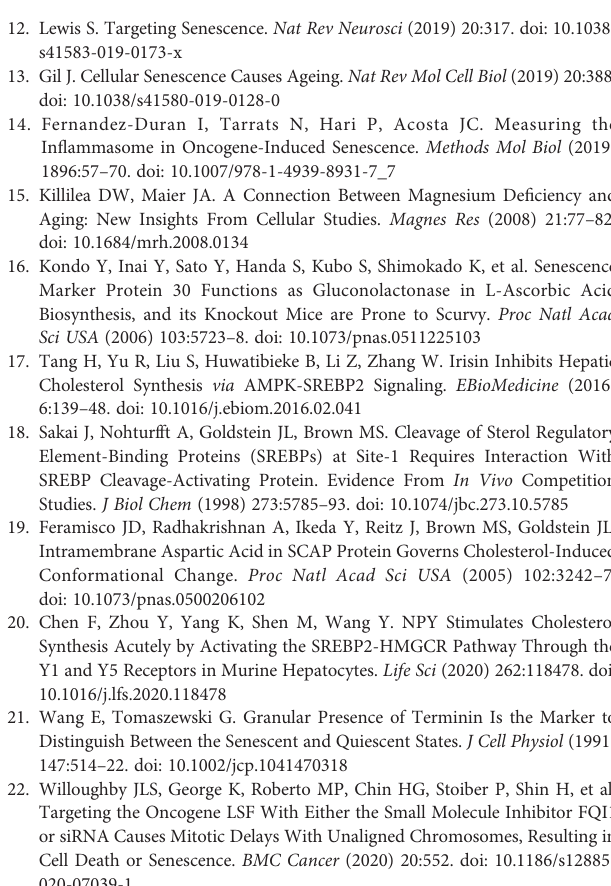
Supplementary Figure 1 | TFCP2 was up-regulated in pancreatic cancer. (A) Immunohistochemistry (IHC) was performed to examined the protein levels of TFCP2 in the pancreatic cancer tissues (cancer) and adjacent non-cancerous tissues (normal). (B) The protein levels of TFCP2 in the pancreatic tissues of KC mice aged 2 or 8 months. (C) IHC was performed to examined the protein levels of TFCP2 in the pancreatic cancer tissues with wide-type or mutant Kras. The magni fi cation was 10-fold. Supplementary Figure 2 | SREBP2 and HMGCR was up-regulated in pancreatic cancer. Western blot was performed to examine the levels of SREBP2 and HMGCR protein in 6 pancreatic cancer tissues and paired non-cancerous